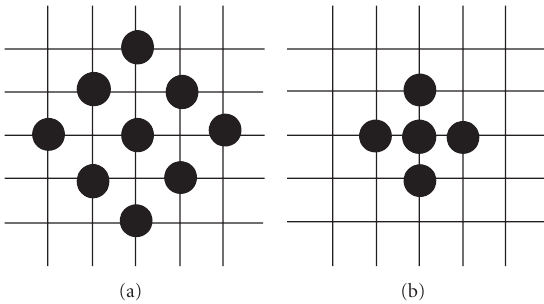
Figure 4: LDPS at the left and SDSP at the right [8].